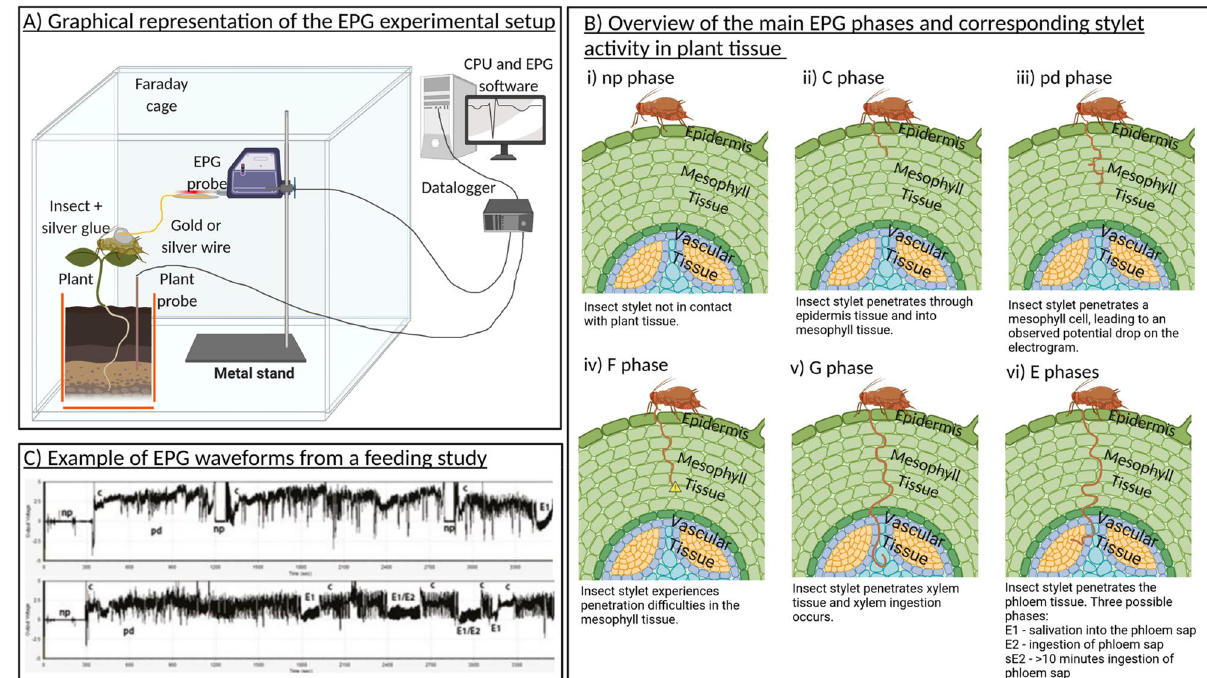
Figure 1. ( A ) Overview of an EPG experimental setup. ( B ) An indication of the location of the insect stylet in the plant tissue for the main EPG phases (i–vi). ( C ) Example EPG waveforms from Leybourne et al. 18 redistributed with publisher permissions. This image was created with